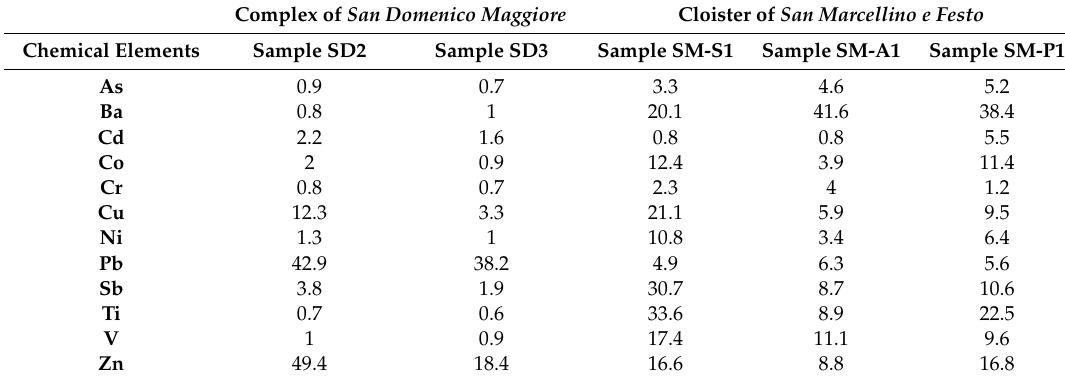
Table 5. Enrichment factors (EFs) of the chemical elements detected in the black crusts: EFs > 1 (values in green cells); EFs = 1 (values in white cells); EFs < 1 (values in red cells). Complex of San Domenico Maggiore Cloister of San Marcellino e Festo Chemical Elements Sample SD2 Sample SD3 Sample SM-S1 Sample SM-A1 Sample